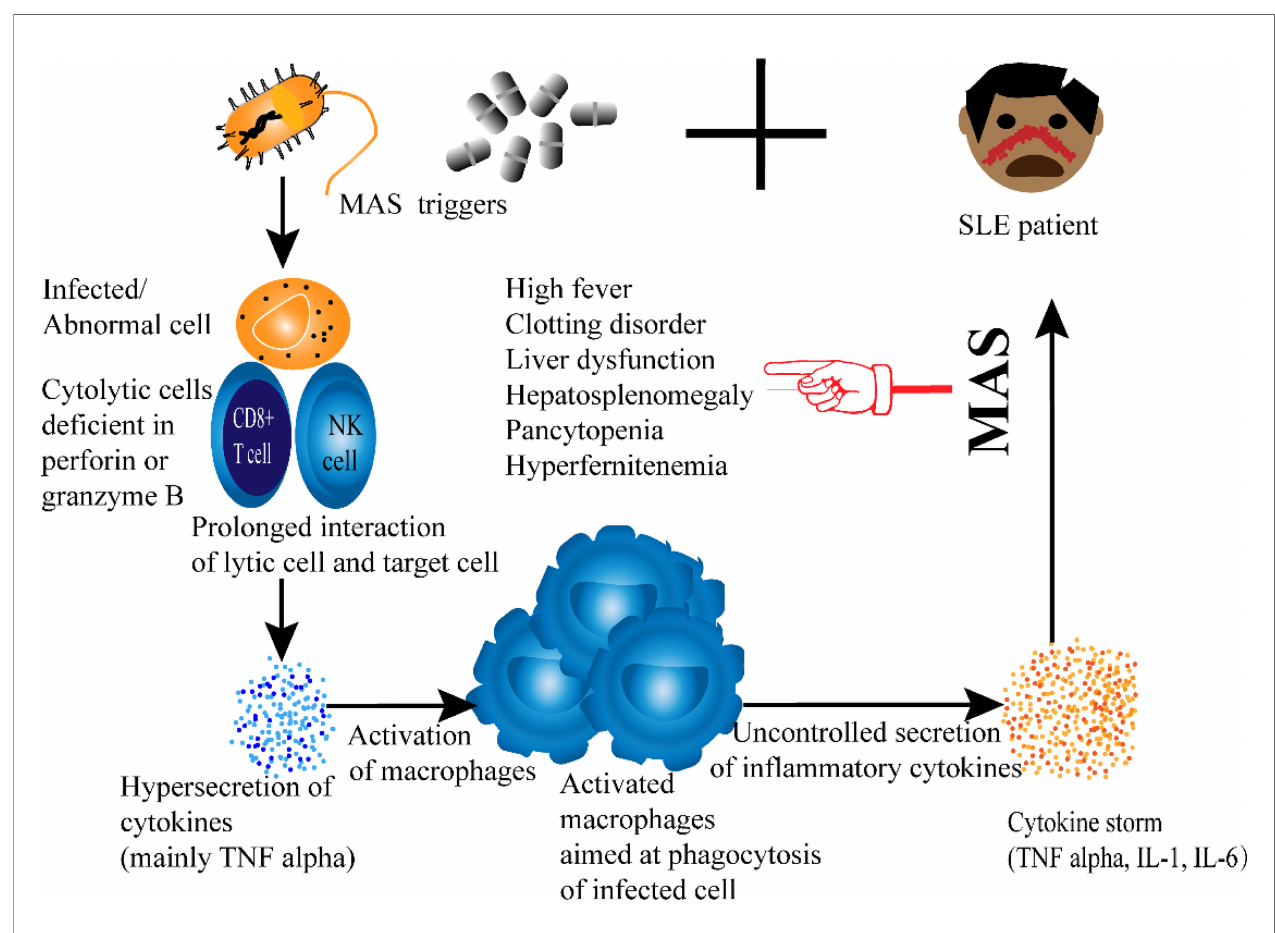
FIGURE 2 | Proposed Pathogenesis of SLE-associated